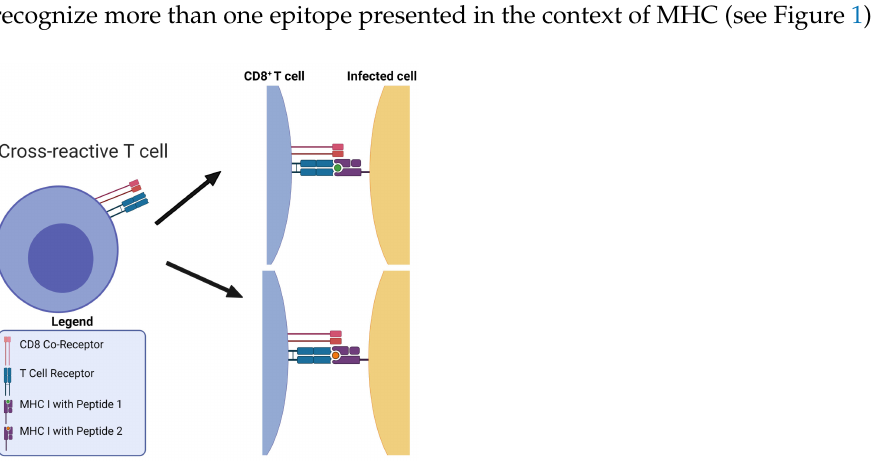
Figure 1. Definition of TCR cross-reactivity. Presentation of two distinct epitopes in the context of MHC-I and the recognition of both of these epitopes by a single cross-reactive TCR on a CD8 + T